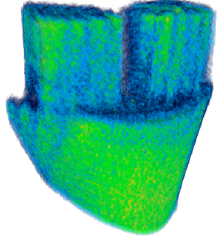
Figure 5. Attenuation volume rendering of the quadratic and cubes at ξ = 338